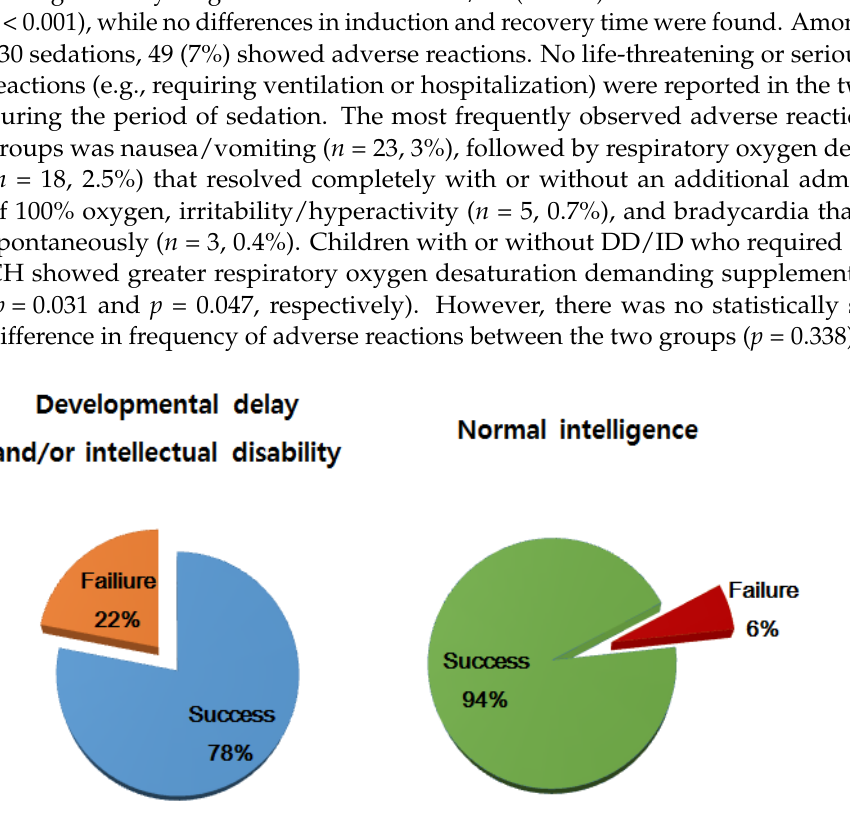
Figure 1. Effectiveness of chloral hydrate in the two groups ( p =